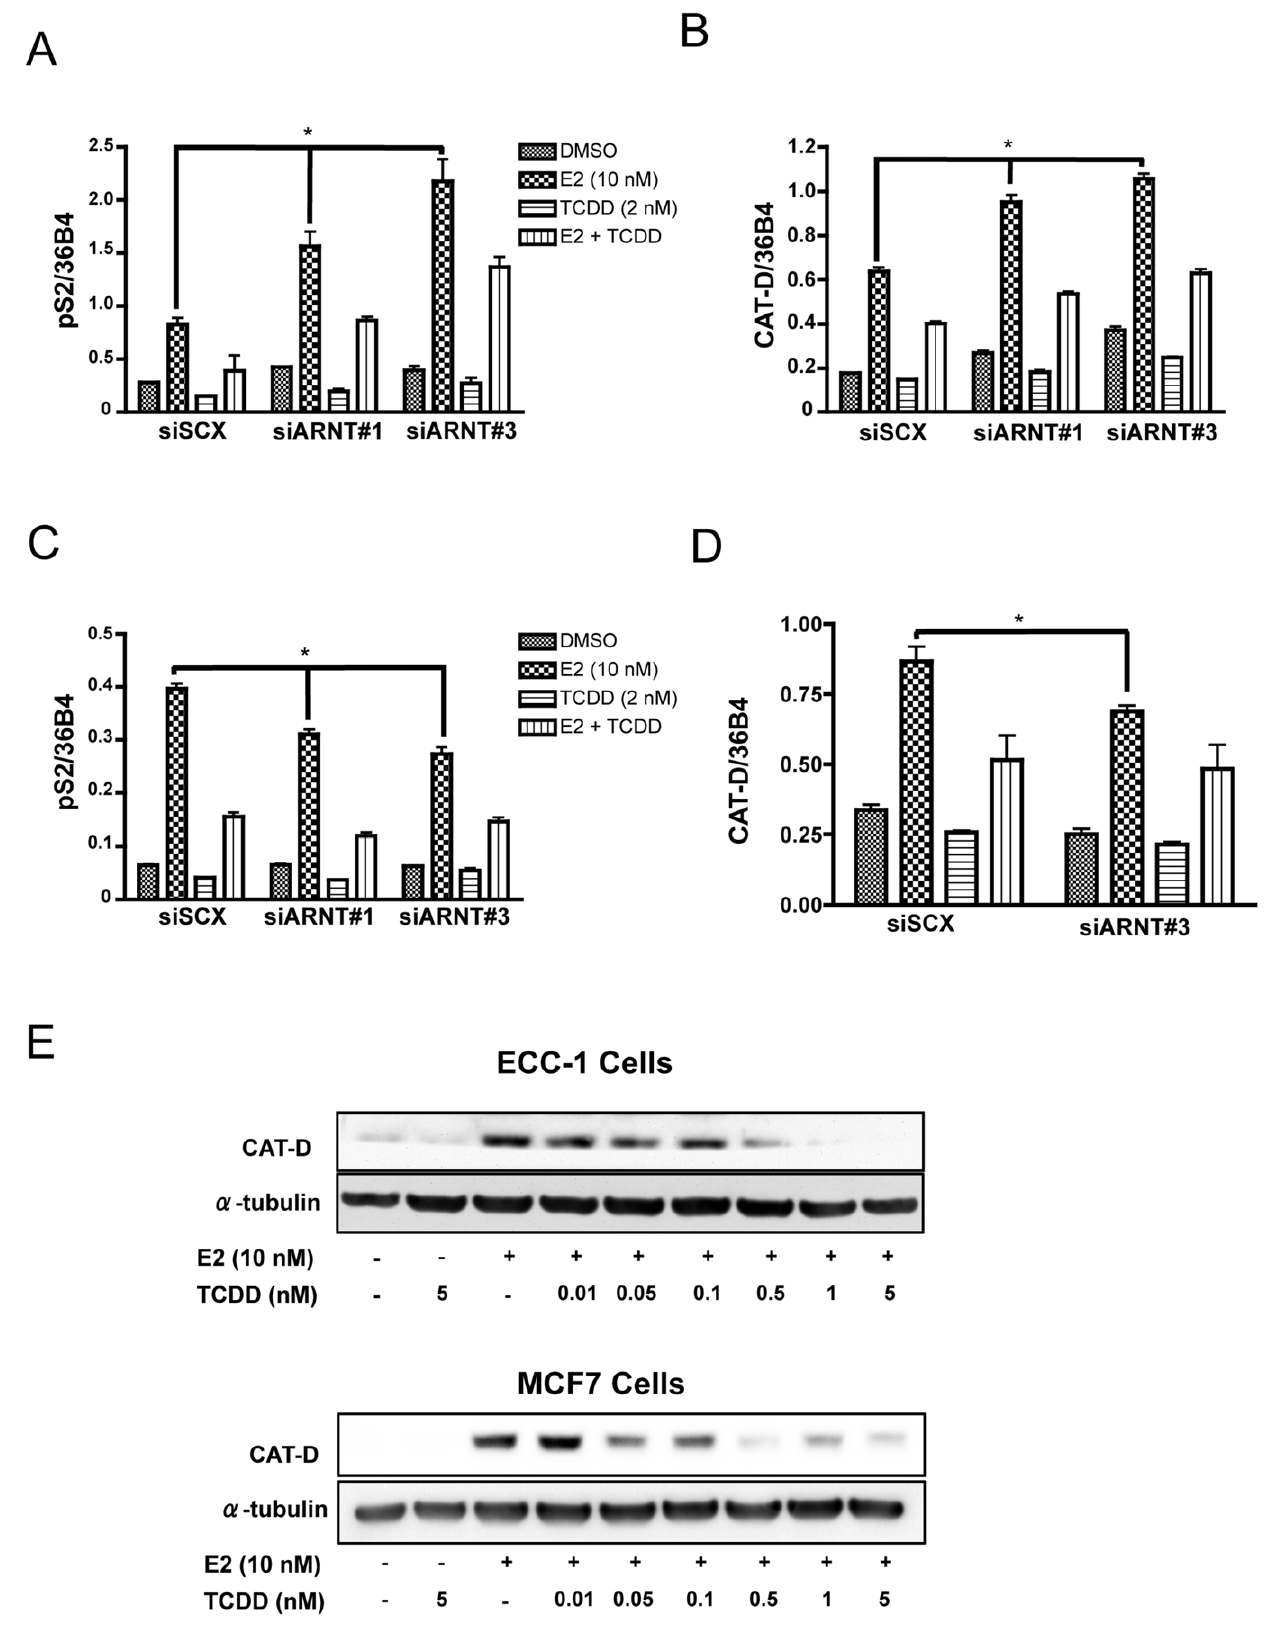
Figure 2. Loss of ARNT shows a cell specific co-activator or co-repressor transcriptional function. ECC-1 cells ( A and B ) and MCF7 cells ( C and D ) were transfected with either scrambled siRNA (siSCX) or siRNA directed to ARNT (siARNT # 1 or siARNT # 3). Twenty-four hours after transfection, cells were treated with vehicle (DMSO), E2 (10 nM), TCDD (2 nM) or a combination of E2 and TCDD. Gene expression was determined by PLoS ONE |